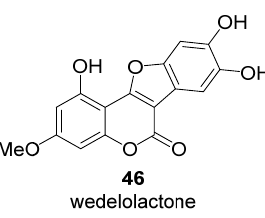
Figure 8. Structure of wedelolactone, a coumestan derivative.